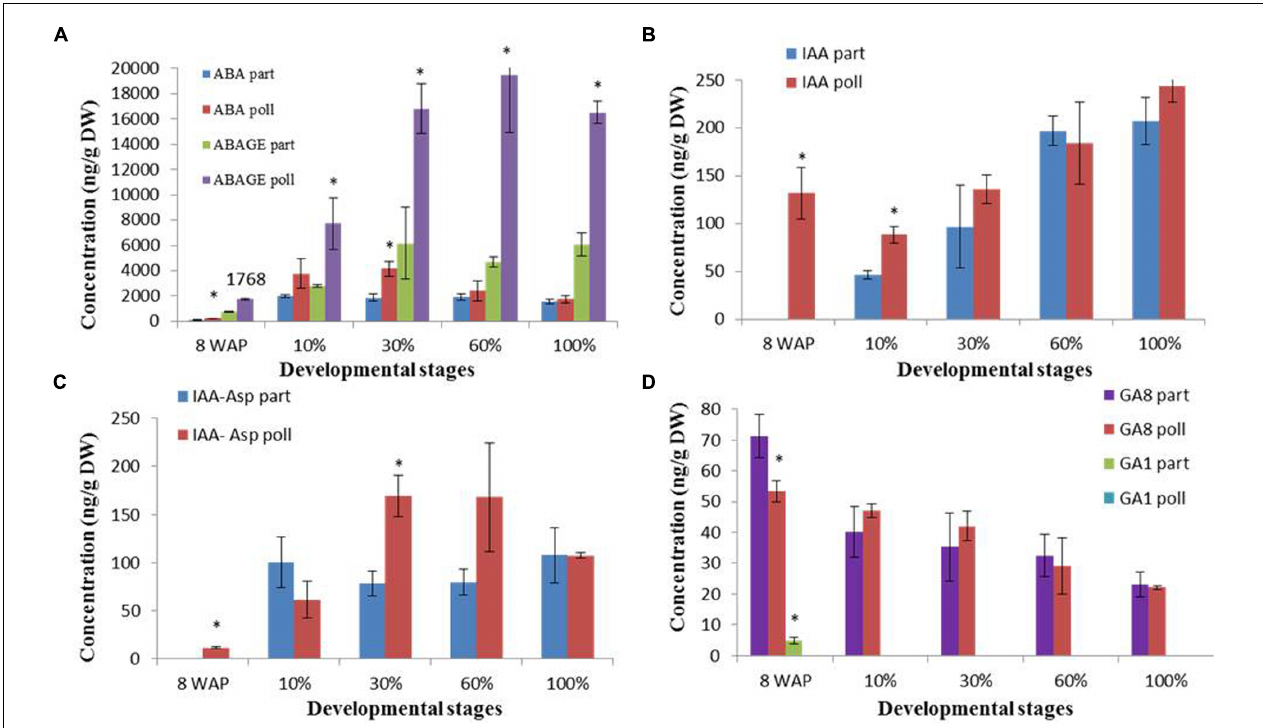
FIGURE 3 | Hormone concentrations during parthenocarpic (part) and pollinated (poll) fig fruit development and ripening. (A) ABA and ABA–GE (ABAGE). (B) IAA. (C) The IAA–Asp conjugate. (D) GA1 and GA8. Average ± SE of two replicates of 15 fruits per treatment. Bars represent standard error. Asterisk represent statistical significance determined using Student’s t